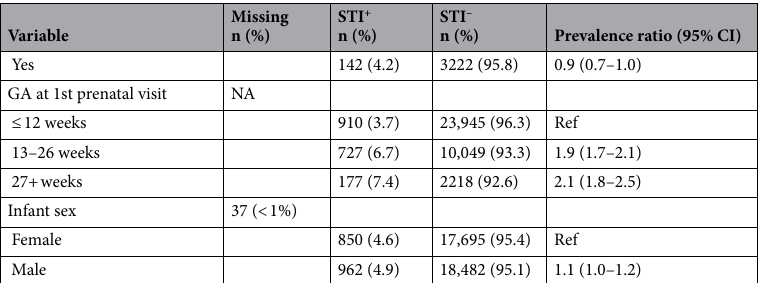
Table 1. Maternal demographic and clinical characteristics by non-viral sexually transmitted infection (STI) status. Log-binomial logistic regression was used to calculate point prevalence ratios and 95% confidence intervals. PI Pacific Islander, HS High School, BMI body mass index, CHIP Children’s Health Insurance Program, GA gestational age.